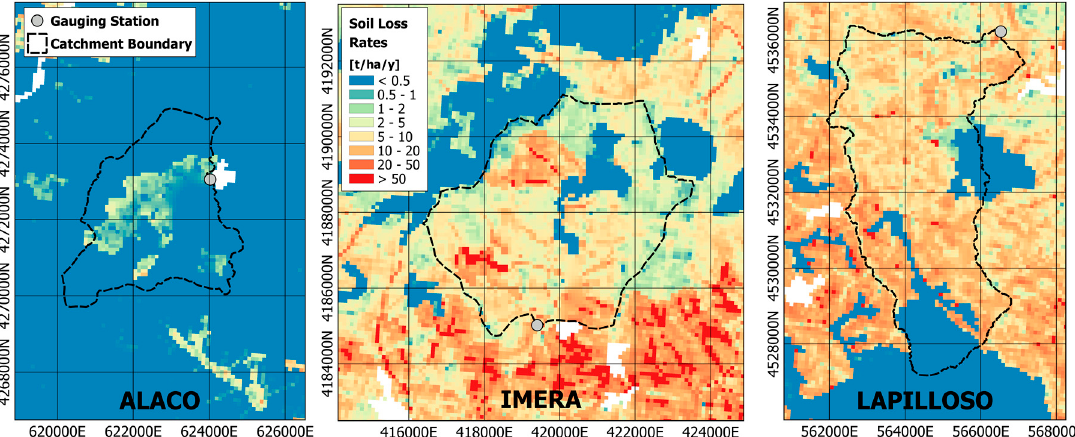
Figure 7. Catchment soil-loss maps derived from the Soil Erosion Map of Europe [34]. Coordinate system: ED50-UTM33N (EPSG 23033).